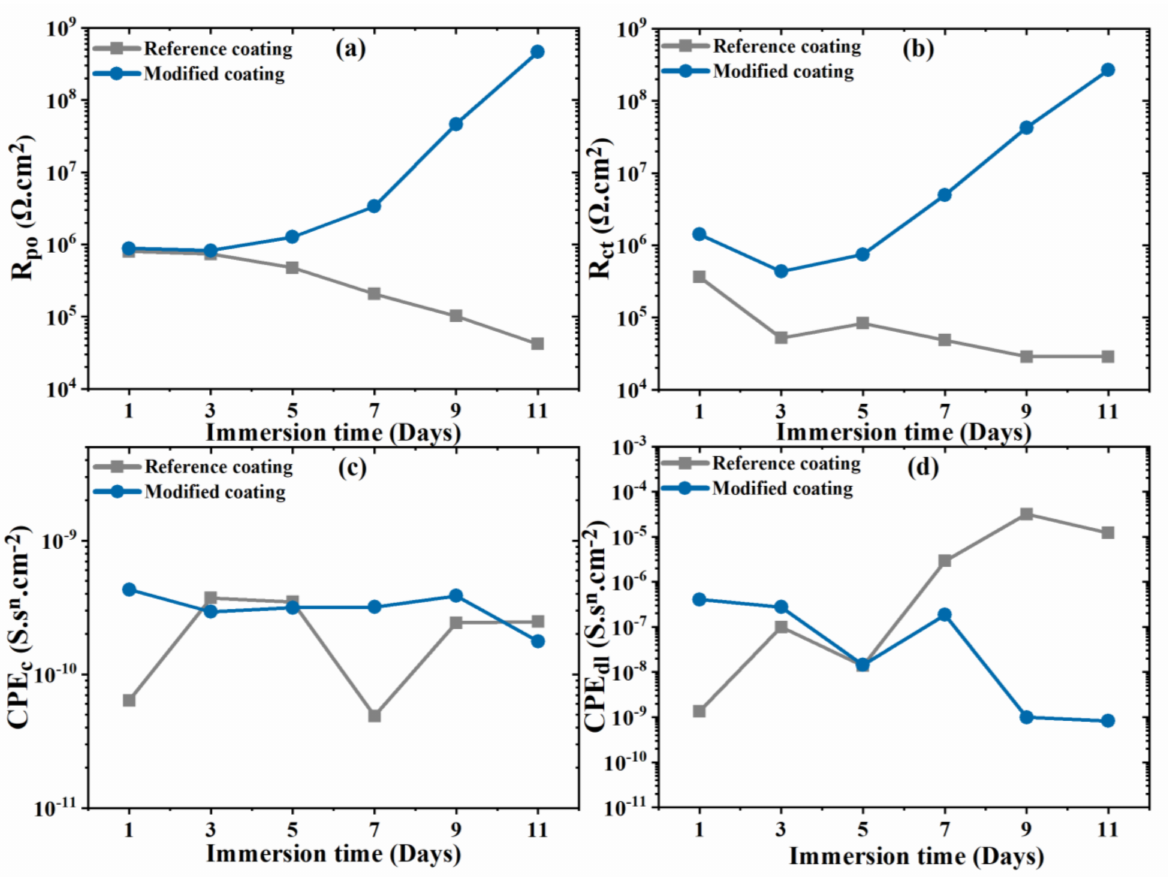
Figure 8. ( a ) Evolution of the pore resistance (R po ), ( b ) Faradic resistance (R ct ), ( c ) admittance of coating (CPE c ), ( d ) admittance of the double layer (CPE dl